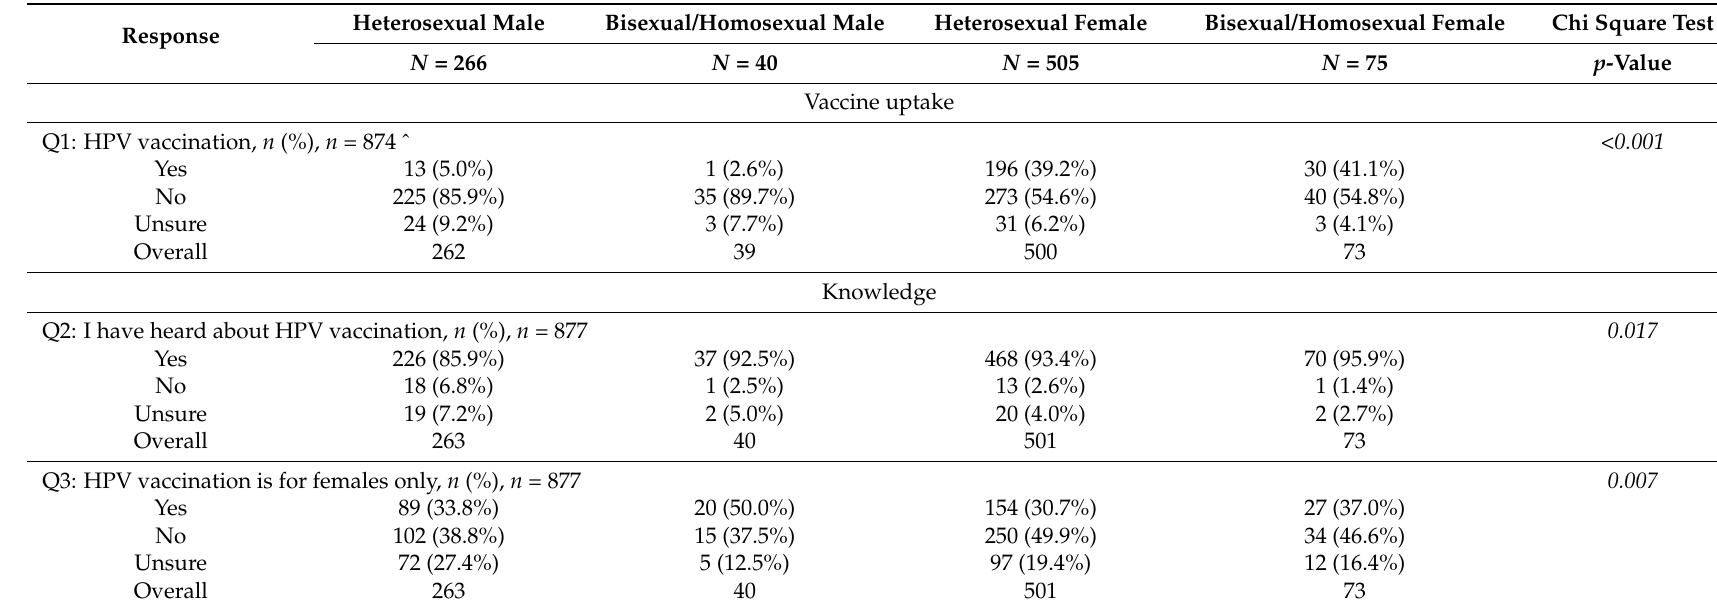
Table 2. The prevalence of HPV vaccination and HPV-related knowledge by sexual